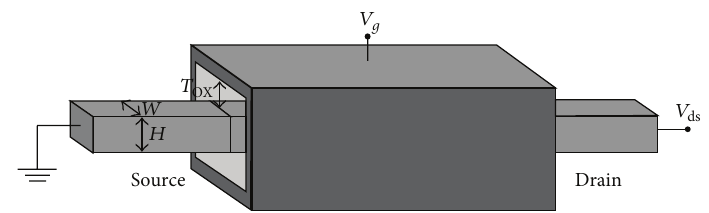
Figure 1: Schematic diagram of a gate-all-around SiNW